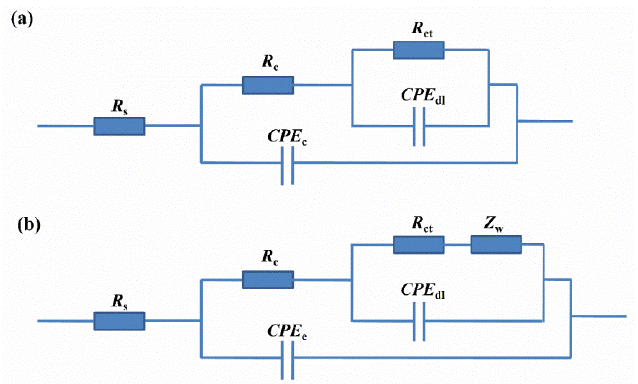
Figure 17. Equivalent circuits used to fit the EIS data in Figures 13–16 ( a ) with two time constants; ( b ) with three time constants. ( b ) with three time